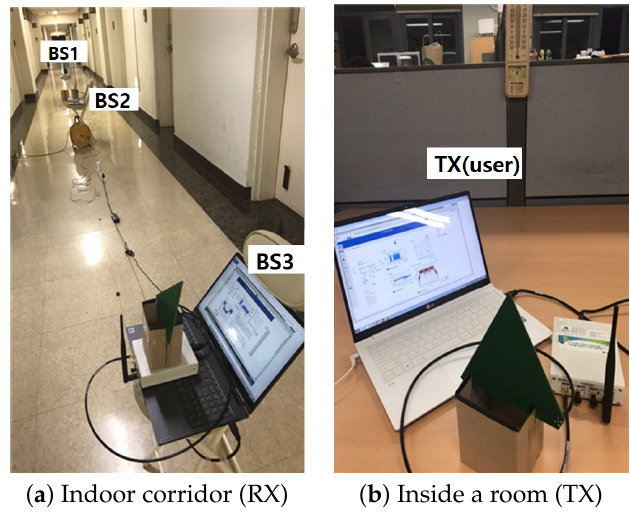
Figure 8. Bit error rate (BER) performance measurement set-up for NLoS environment.